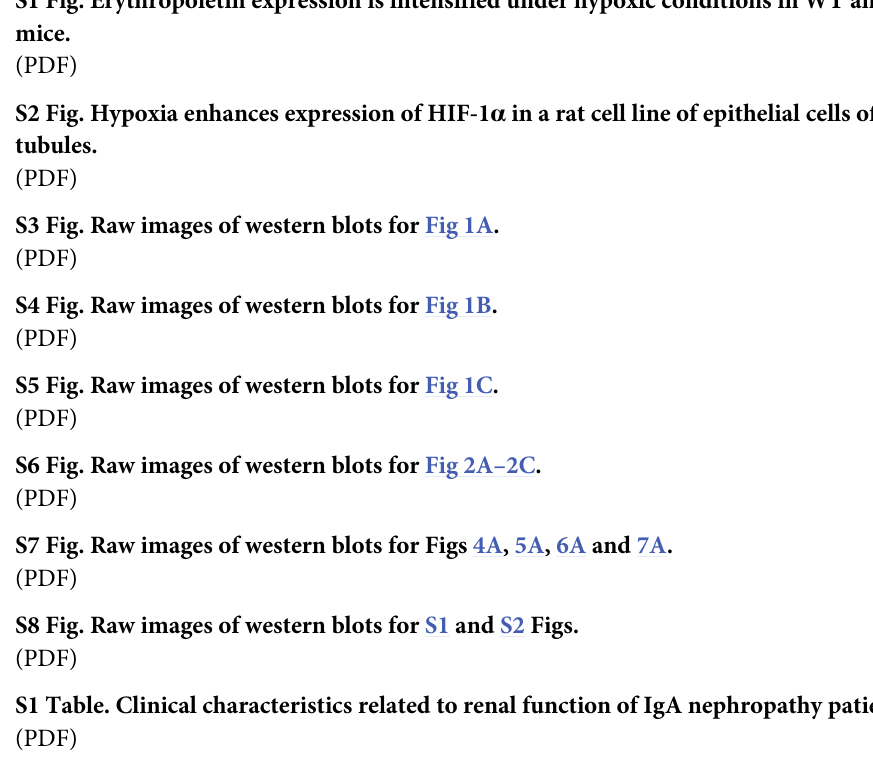
S1 Table. Clinical characteristics related to renal function of IgA nephropathy